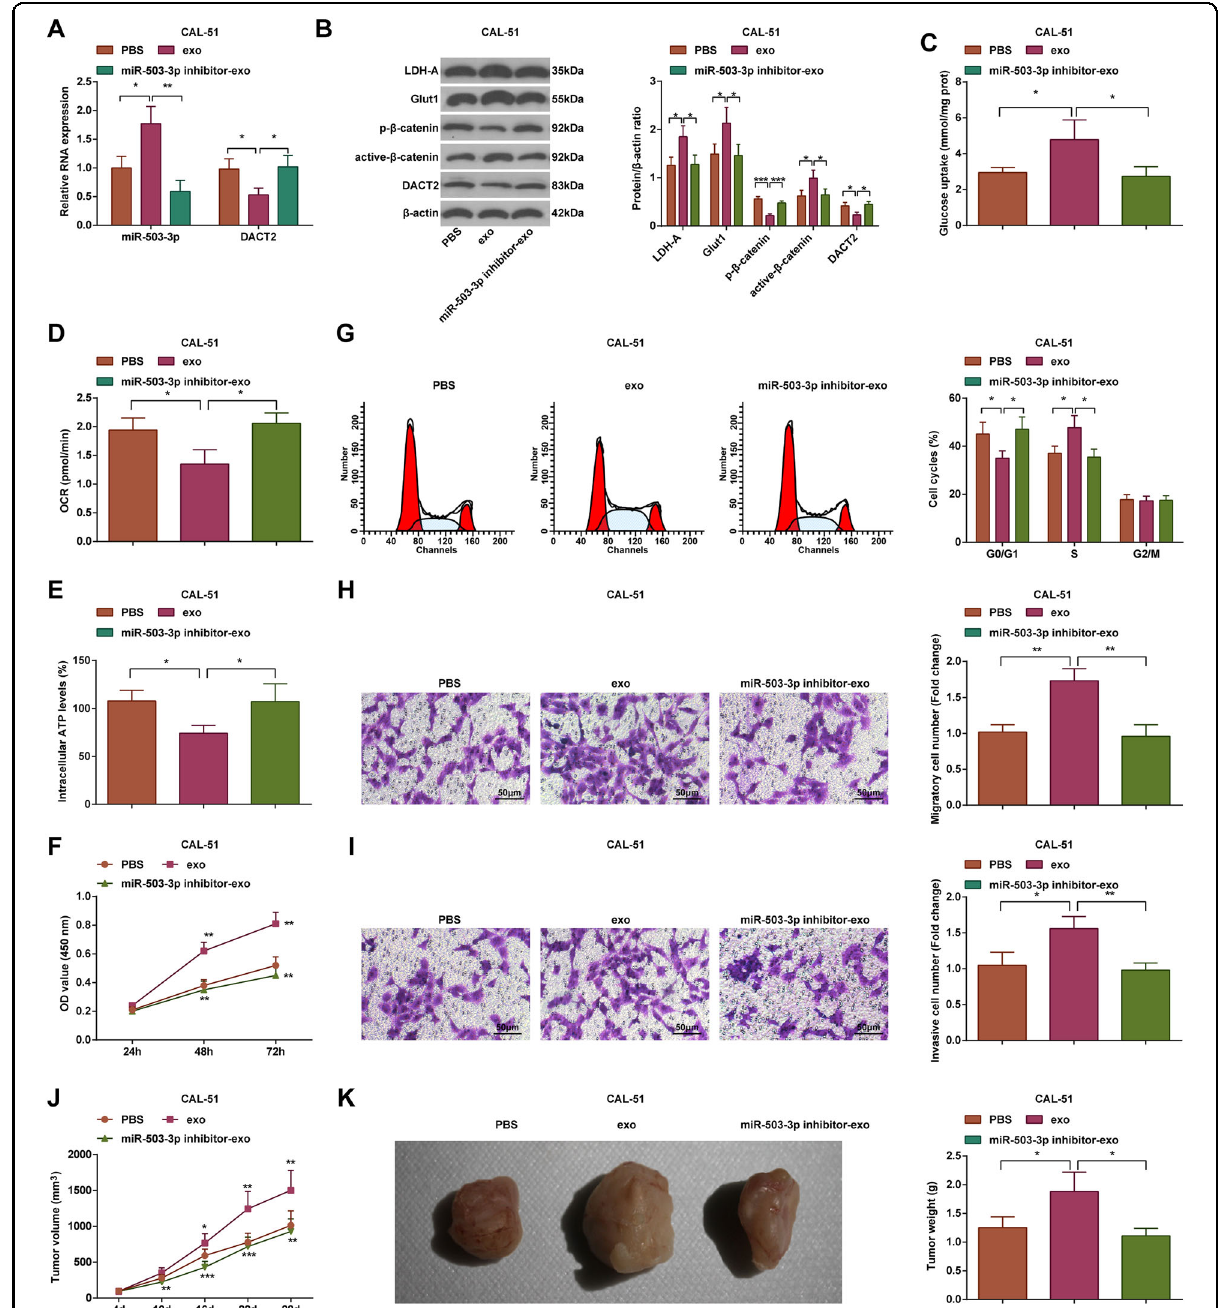
Fig. 5 Macrophage-derived exosomal miR-503-3p activates the Wnt/ β -catenin signaling pathway, promotes glycolysis, and reduces mitochondrial OXPHOS in BC cells. A RT-qPCR measured miR-503-3p and DACT2 expression in CAL-51 cells; B western blot analyzed DACT2, active- β -catenin, p- β -catenin, Glut1, and LDH-A protein expression in CAL-51 cells; C glucose intake of CAL-51 cells; D oxygen consumption rate of CAL-51 cells; E ATP level in CAL-51 cells; F CAL-51 cell viability; G fl ow cytometry determined cell cycle distribution; H , I Transwell assay tested migration and invasion ability of CAL-51 cells; J , K tumor volume and weight of nude mice that had been injected with CAL-51 cells; repetitions = 3 in ( A – I ), n = 6 in ( J , K ); * P < 0.05; ** P < 0.01; *** P < 0.001; data of groups were compared using one-way ANOVA, and were expressed as mean ± standard